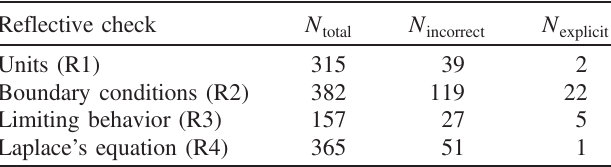
TABLE VI. Number of exam students who explicitly utilized each of the four possible reflective checks ( N ) along with explicit the number of solutions that included an error that would have been detected by this check ( N ). N represents the total incorrect total number of solutions that reached a point where they could have utilized that reflective check. The limiting behavior check applies only to exams that asked for V , and the two semesters in outside which students were directly prompted to consider limiting behavior are excluded; this accounts for the lower N total